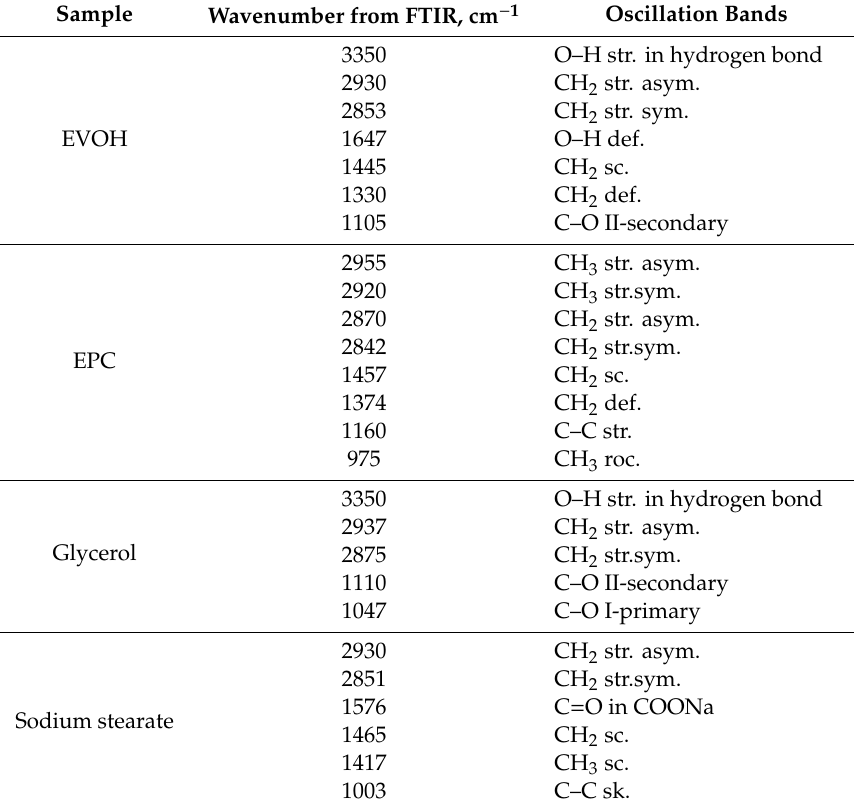
Table 5. Wavenumbers of the bands observed in the FTIR spectra of EVOH, EPC, glycerol, sodium stearate bands